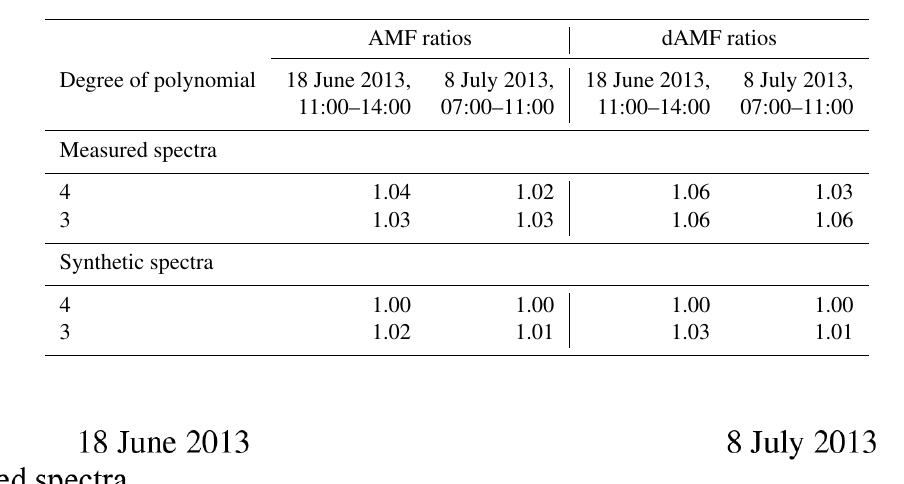
Table A15. Average ratios of O 4 (d)AMFs derived for different polynomials vs. those for the standard analysis (polynomial degree 5) for the middle periods on each selected day (top: results for spectra measured by the MPIC instrument; bottom: results for synthetic spectra when taking into account the temperature dependence of the O 4 cross section).